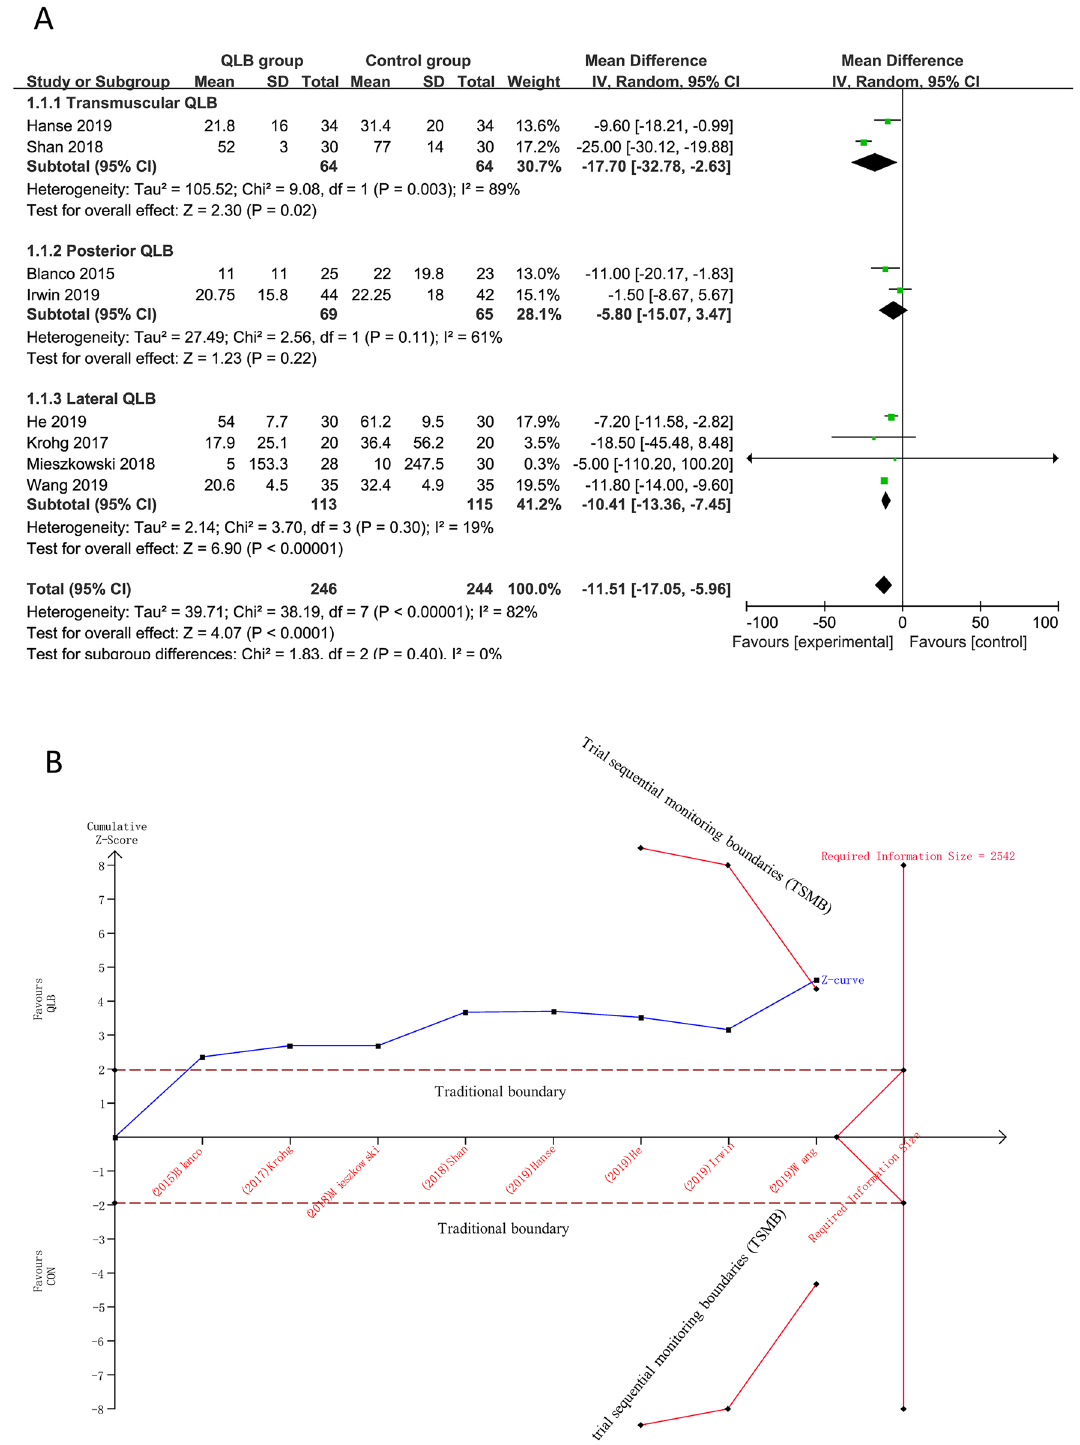
Figure 3. The results of meta-analysis and TSA for 24 h intravenous morphine equivalent consumption. ( A ) meta-analysis of cumulative 24-h morphine equivalent consumption; ( B ) TSA of cumulative 24-h morphine equivalent